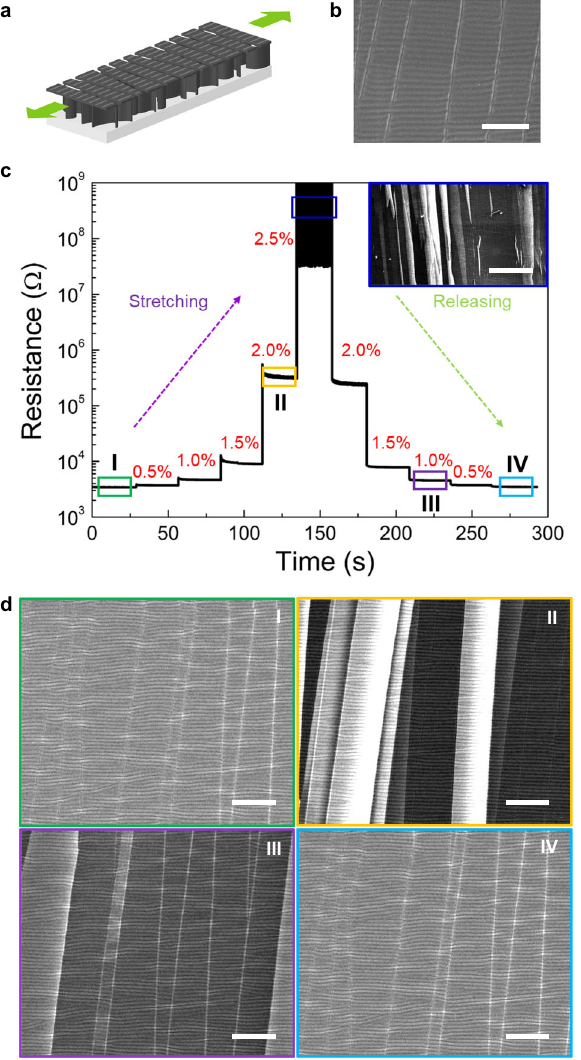
Fig. 2 Restorable and stable VGS-V behavior. a Illustration of VGS when the elongated direction is perpendicular to the cracks on the BFG. b Enlarged SEM image of surface on BFG, clearly showing well-aligned cracks on the BFG. Scale bar, 50 μ m. c Resistance as a function of time with applied stepwise strain. Approaching 2.5% strain, the resistance reaches in unmeasurable range, namely, the current path is broken, which the corresponded in situ SEM image is shown in the inset (Scale bar, 500 μ m). However, the resistance is restored after the strain is released, and the post-overloaded resistance is almost the same to the pre-overloaded resistance at each strain. d In situ SEM images of VGS during stretching (I (0%), green box and II (2%), yellow box)/releasing (III (1%), purple box and IV (0%), blue box), which are corresponded to those boxes in ( c ). Scale bar, 200 μ